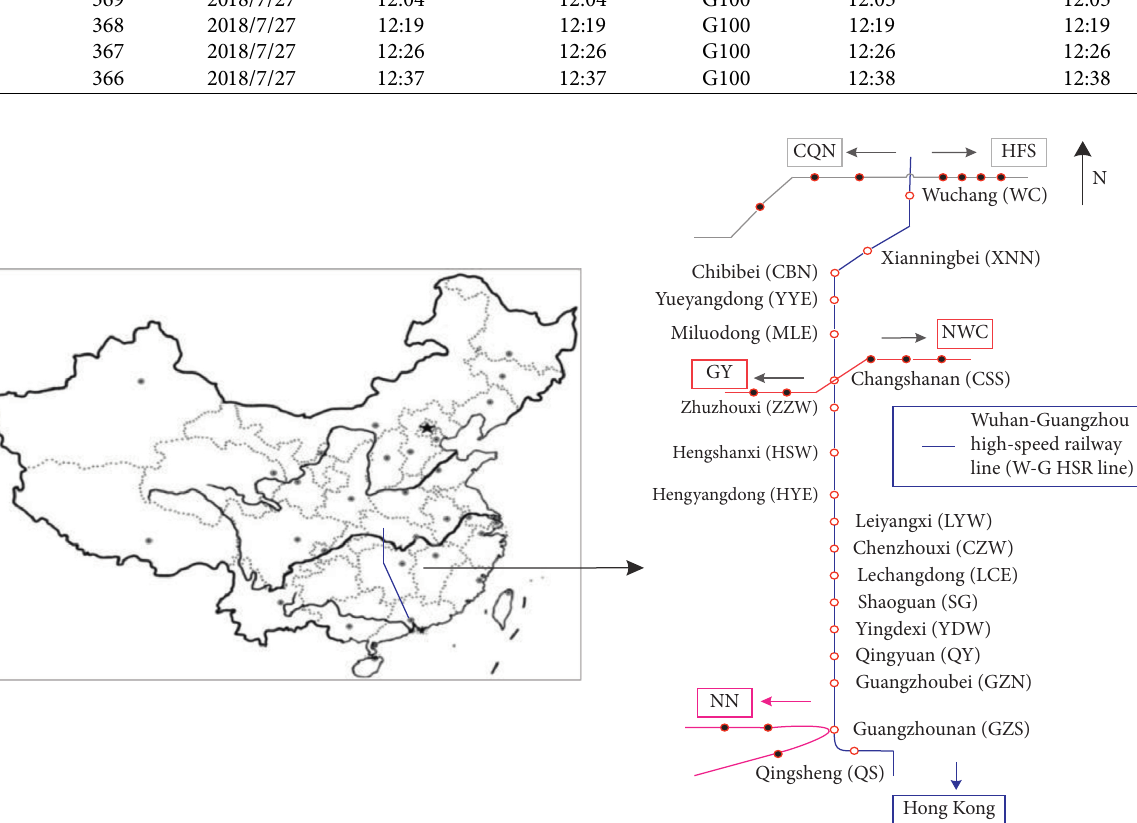
Figure 4: Map of the W-G HSR